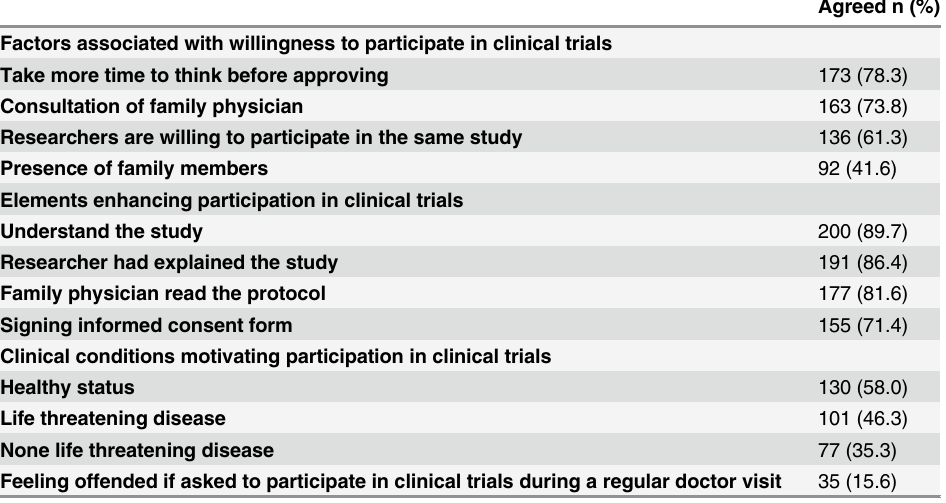
Table 4. Attitudes of study population towards participating in clinical